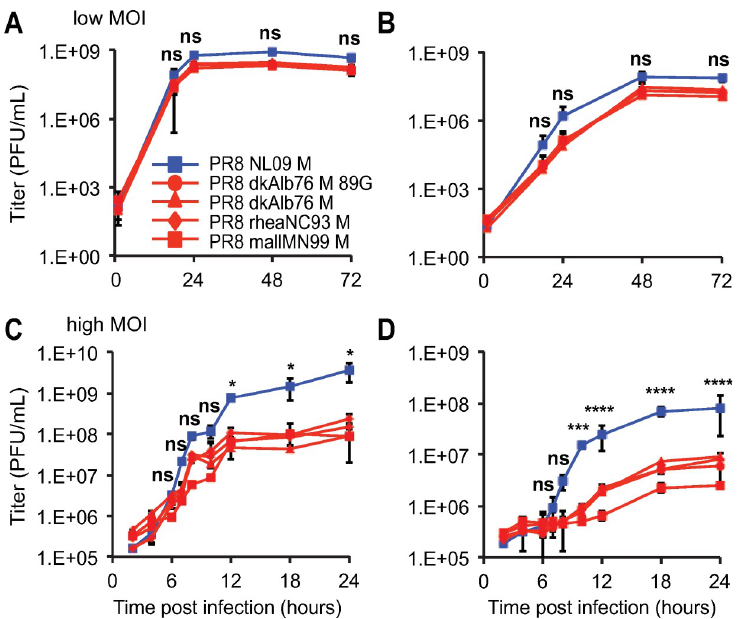
Fig 2. pH1N1 M segment confers higher growth relative to avian M segment in mammalian cells at 37˚C. (A) Canine MDCK cells or (B) human A549 cells were inoculated with the indicated viruses at a low MOI of 0.01 PFU/cell. (C) MDCK cells or (D) A549 cells were inoculated with the indicated viruses at a high MOI of 5 PFU/cell. In mammalian cells, the pH1N1 M segment conferred more rapid kinetics and higher peak titers than any avian-origin M segment. Multi-cycle and single-cycle growth were assessed in three independent experiments, with three technical sample replicates per experiment. Graphs show the means with SD for the three experiments. Statistical significance was determined using repeated measures, two-way, multiple ANOVA on log-transformed values, with Bonferroni correction applied to account for comparison of a limited number of means. At each time point, pairwise comparisons between viruses were performed, and asterisks corresponding to the most significant difference observed is